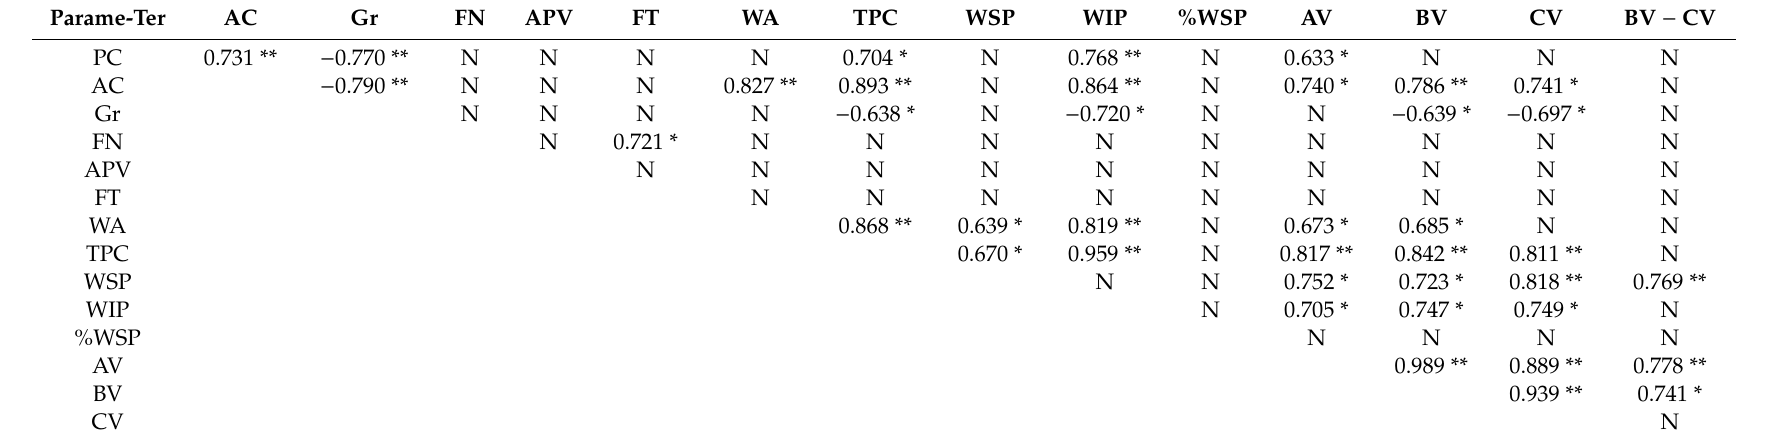
Table 3. Correlation coe ffi cients between parameters describing quality of rye